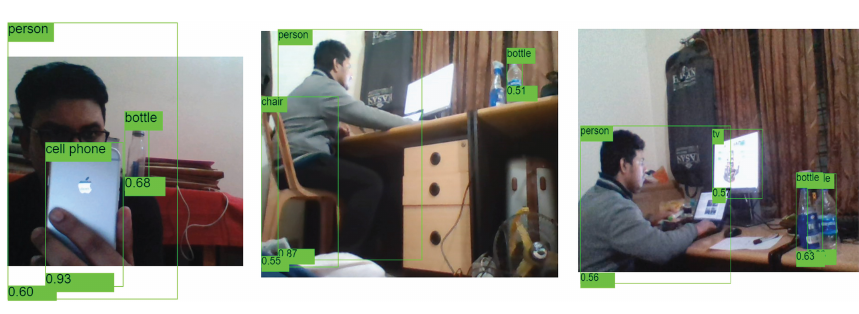
Fig. 4. Sample output of the